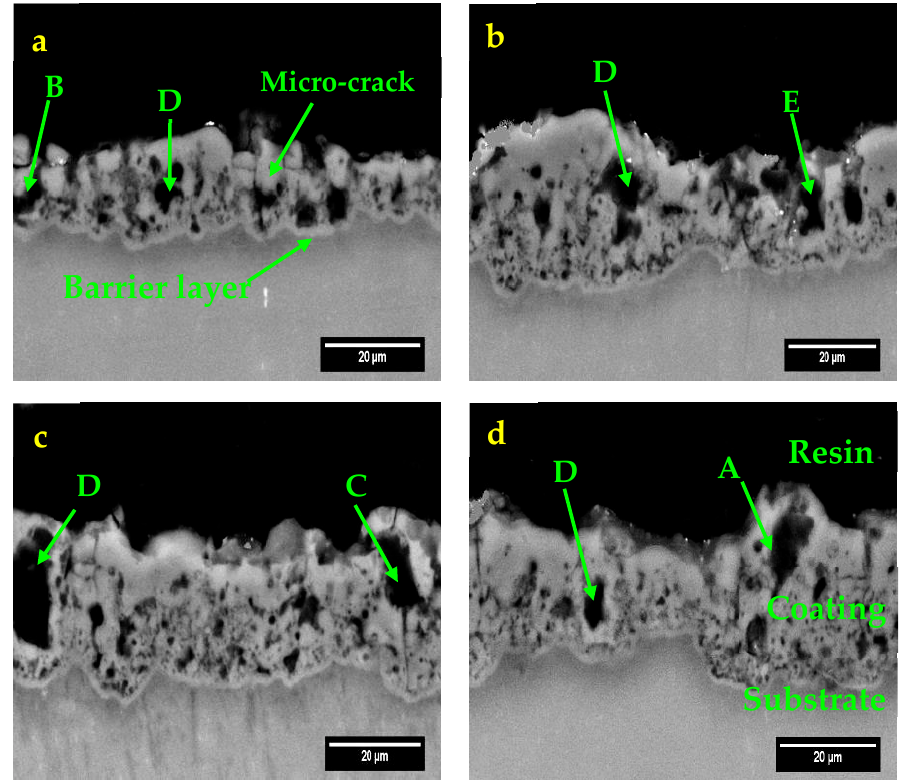
Figure 4. Cross section morphology of the coatings produced using unipolar and bipolar waveforms: ( a ) U, ( b ) B1, ( c ) B2 and ( d ) B3.